Question: Identify the chart type used in this figure.
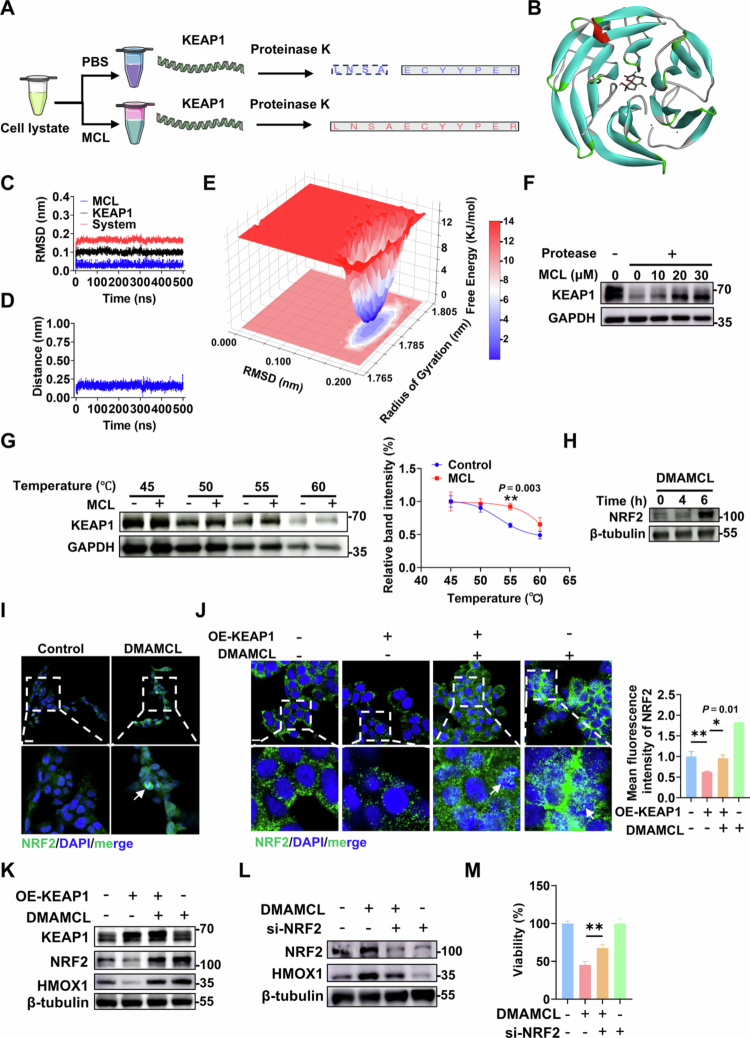
Answer: line